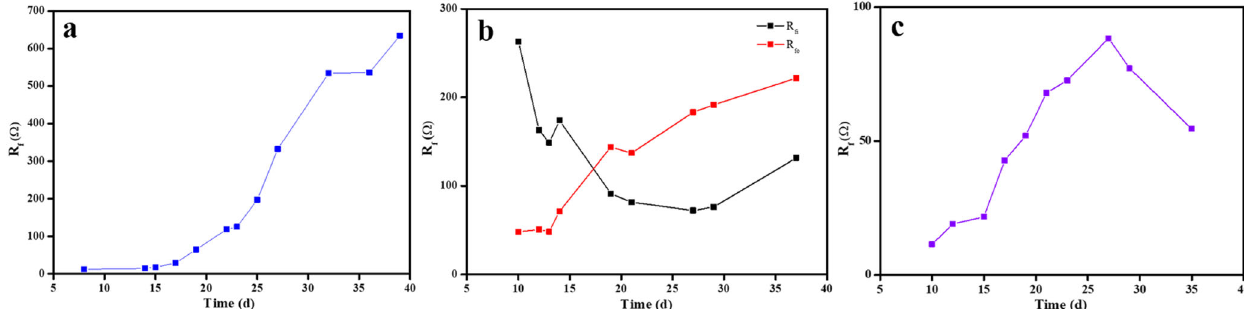
Fig. 10 Resistance of the deposited layer. Variation of the resistance of Ca-Mg deposition layer with time: a 3-1#, b 9-1#, and c